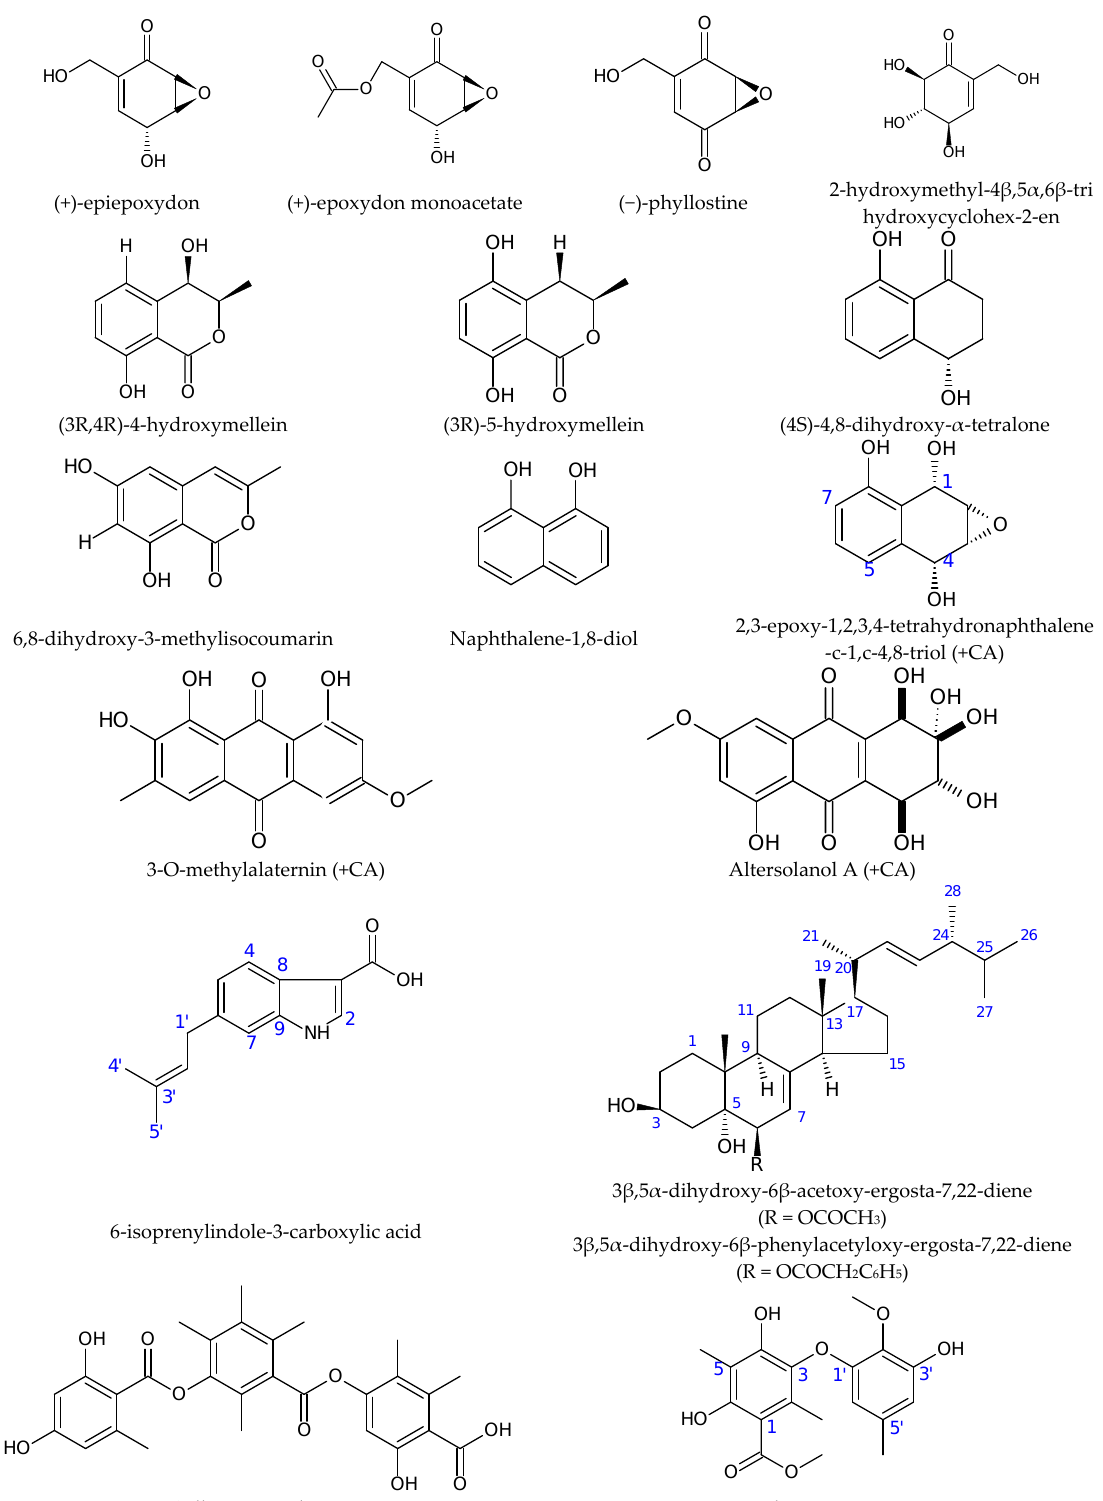
Figure 3. The molecular structure of chosen specific compounds with antibacterial activity synthesized by fungal endophytes associated with Asteraceae species [44,70,96,99,110]; + AF—antifungal activity; + CA—cytotoxic activity.